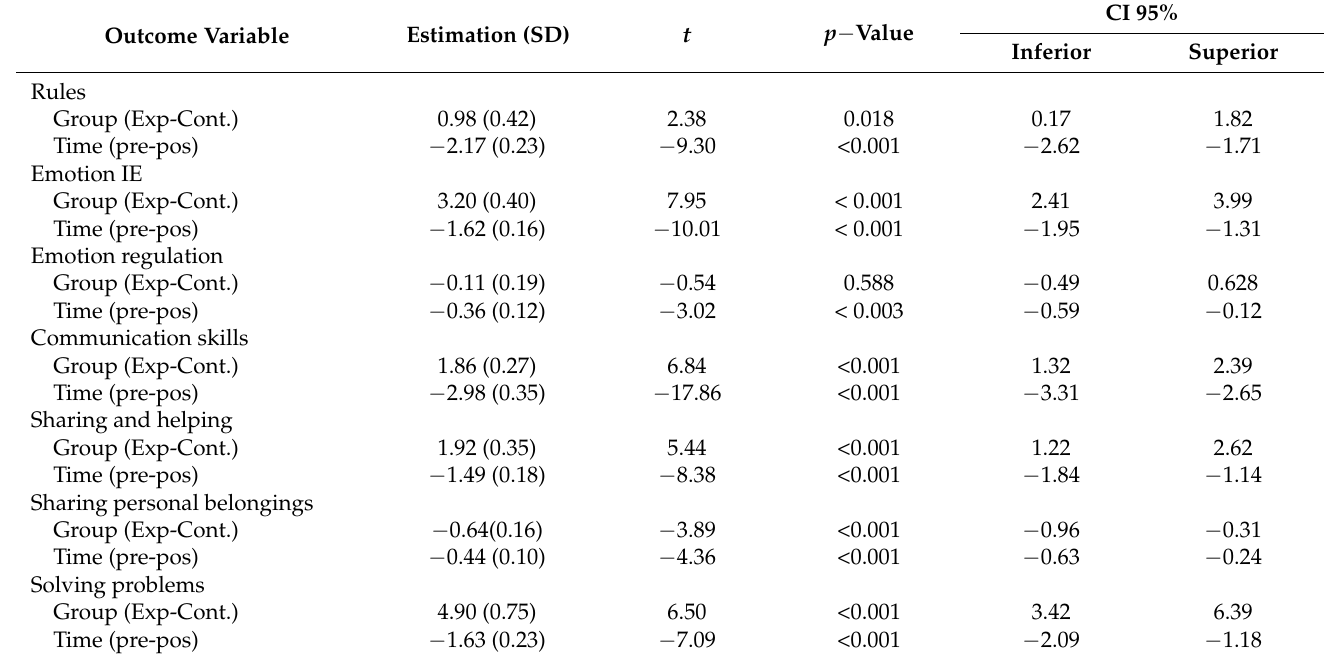
Table 4. Pairwise contrast of groups and times using means estimated by the model on the program’s